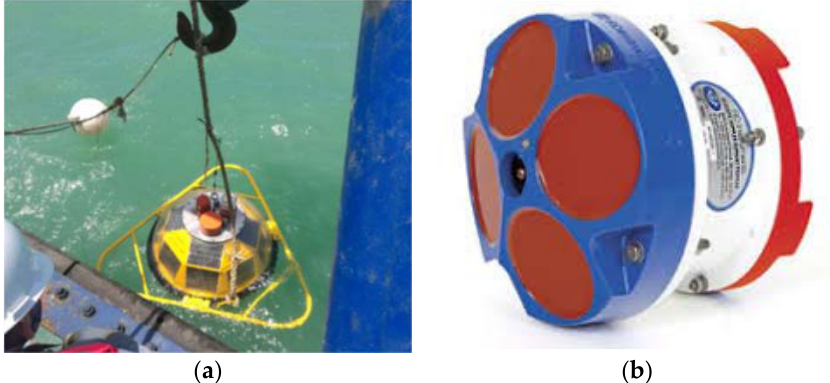
Figure 3. ( a ) Wave observation instruments SBF6 ‐ 2; ( b ) Velocity measurement device, Acoustic Doppler Cassent Profilers (ADCP).